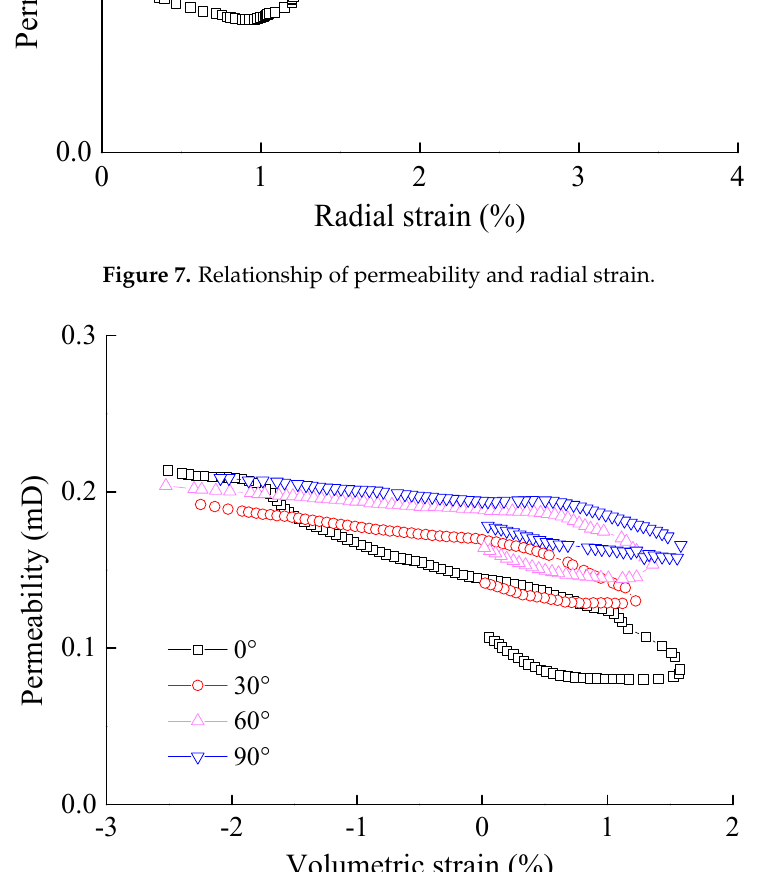
Figure 8. Relationship of permeability and volumetric strain.